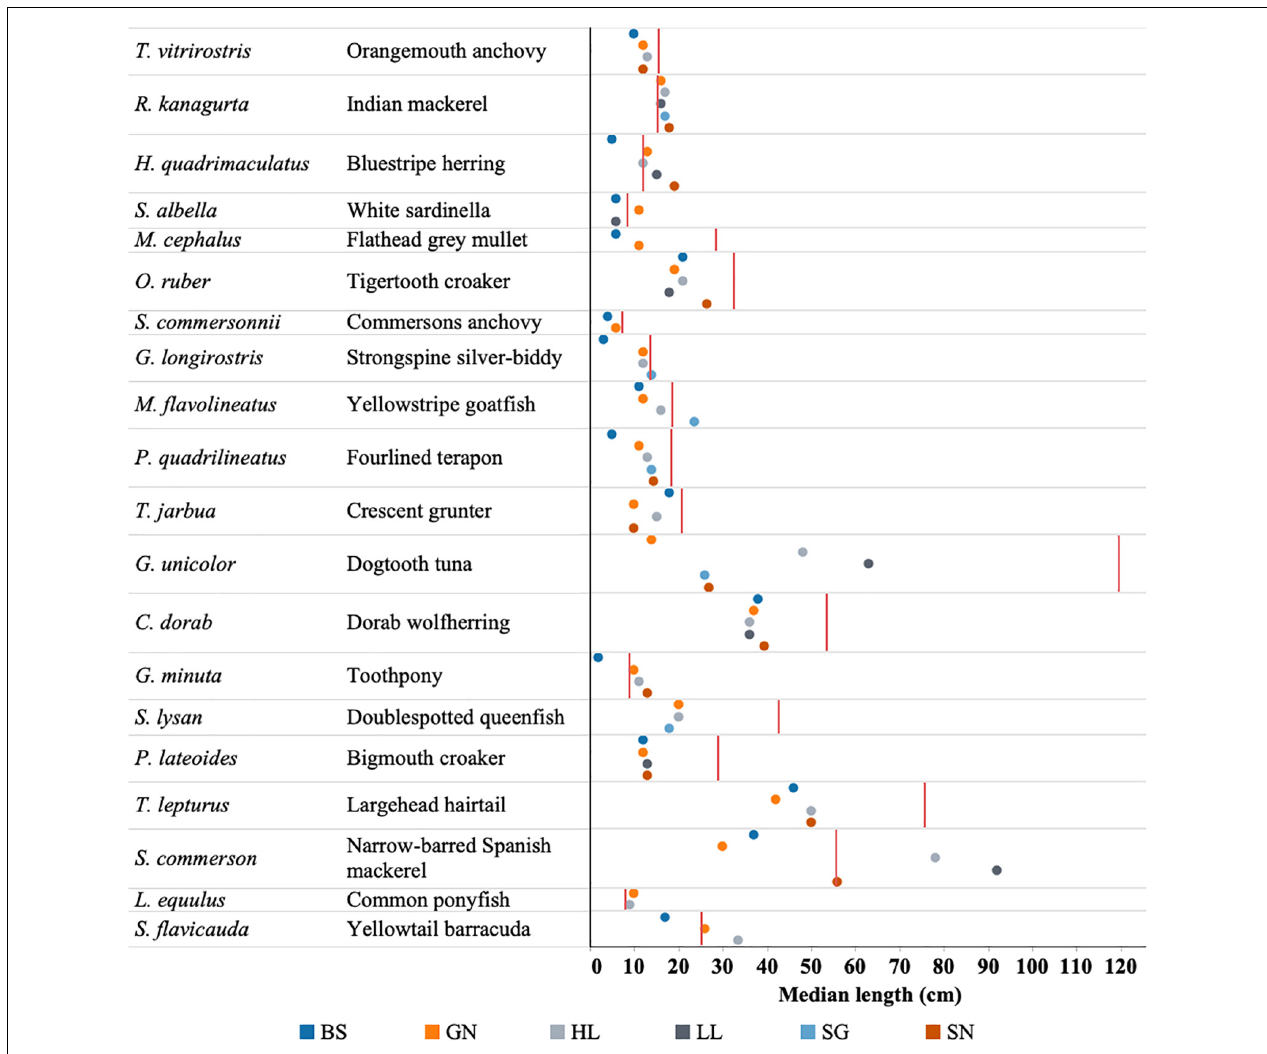
FIGURE 8 | Median length of each of the top 20 fish species caught by each gear type (BS, Beach seine; GN, Gill net; HL, Handline; HS, Hand-spear; LL, Longline; SG, Spear-gun; SN, Shark net) in relation to that species length at maturity (L mat ) denoted by red